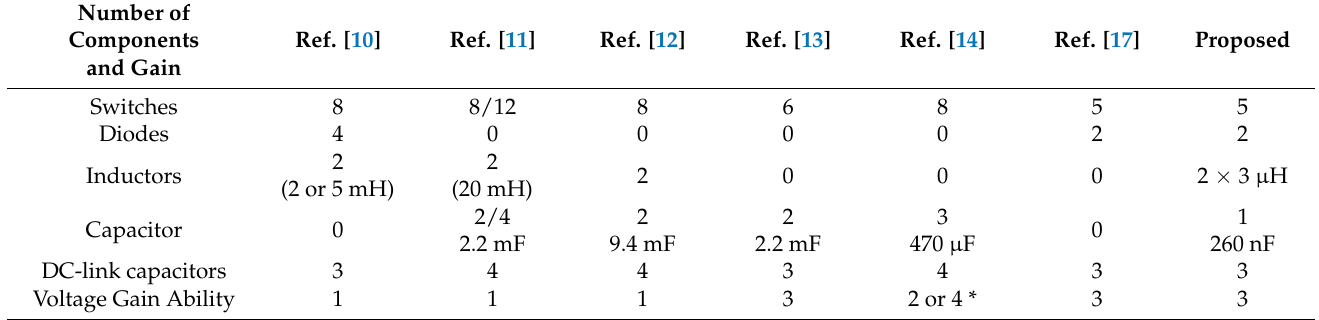
Table 3. Comparison of circuits for voltage